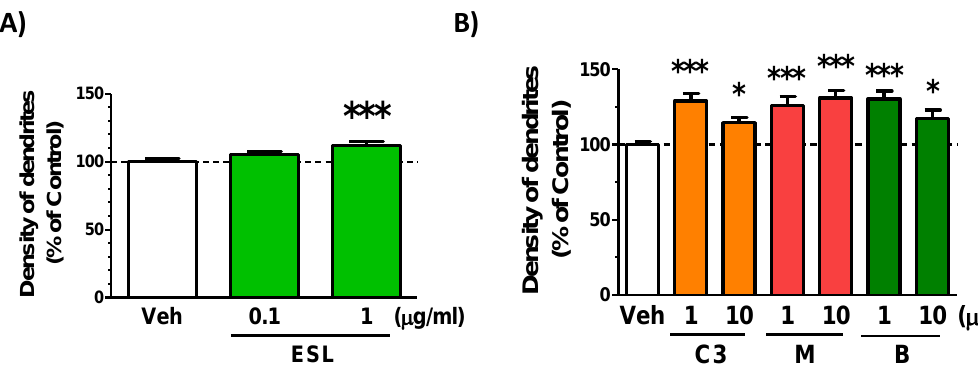
Figure 7. E ff ect of leaf extract and brain penetrated compounds on dedrite growth in cortical neurons. ( A ) Cortical neurons were cultured for three days and then treated with or without the leaf extract (ESL, 0.1 and 1 µ g / mL). Four days after treatment, the cells were fixed and immunostained for MAP2. The density of MAP2-positive dendrites was quantified for each treatment (*** P < 0.0001, one-way ANOVA with post hoc Bonferroni test, n = 58–72). ( B ) Cortical neurons were cultured for three days and then treated with or without ciwujianoside C3 (C3), eleutheroside M (M), ciwujianoside B (B) (each 1 and 10 µ M). Four days after treatment, the cells were fixed and immunostained for MAP2. The density of MAP2-positive dendrites was quantified for each treatment (* P < 0.05, *** P < 0.0001, one-way ANOVA with post hoc Bonferroni test, n = 51–105).